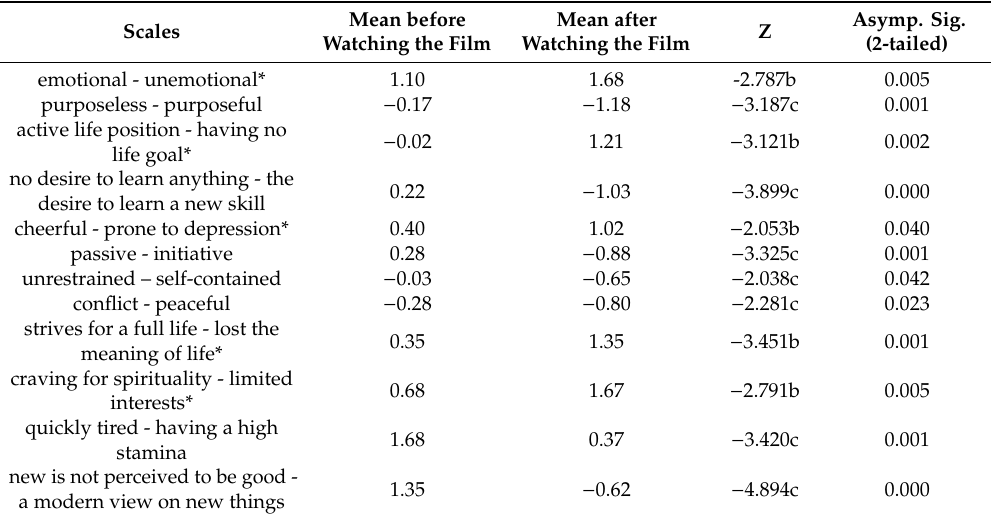
Table 1. Changes in assessments of the elderly people after watching the film (students). Mean before Mean after Asymp. Sig. Z Scales (2-tailed) Watching the Film Watching the Film emotional - unemotional* 1.10 1.68 -2.787b